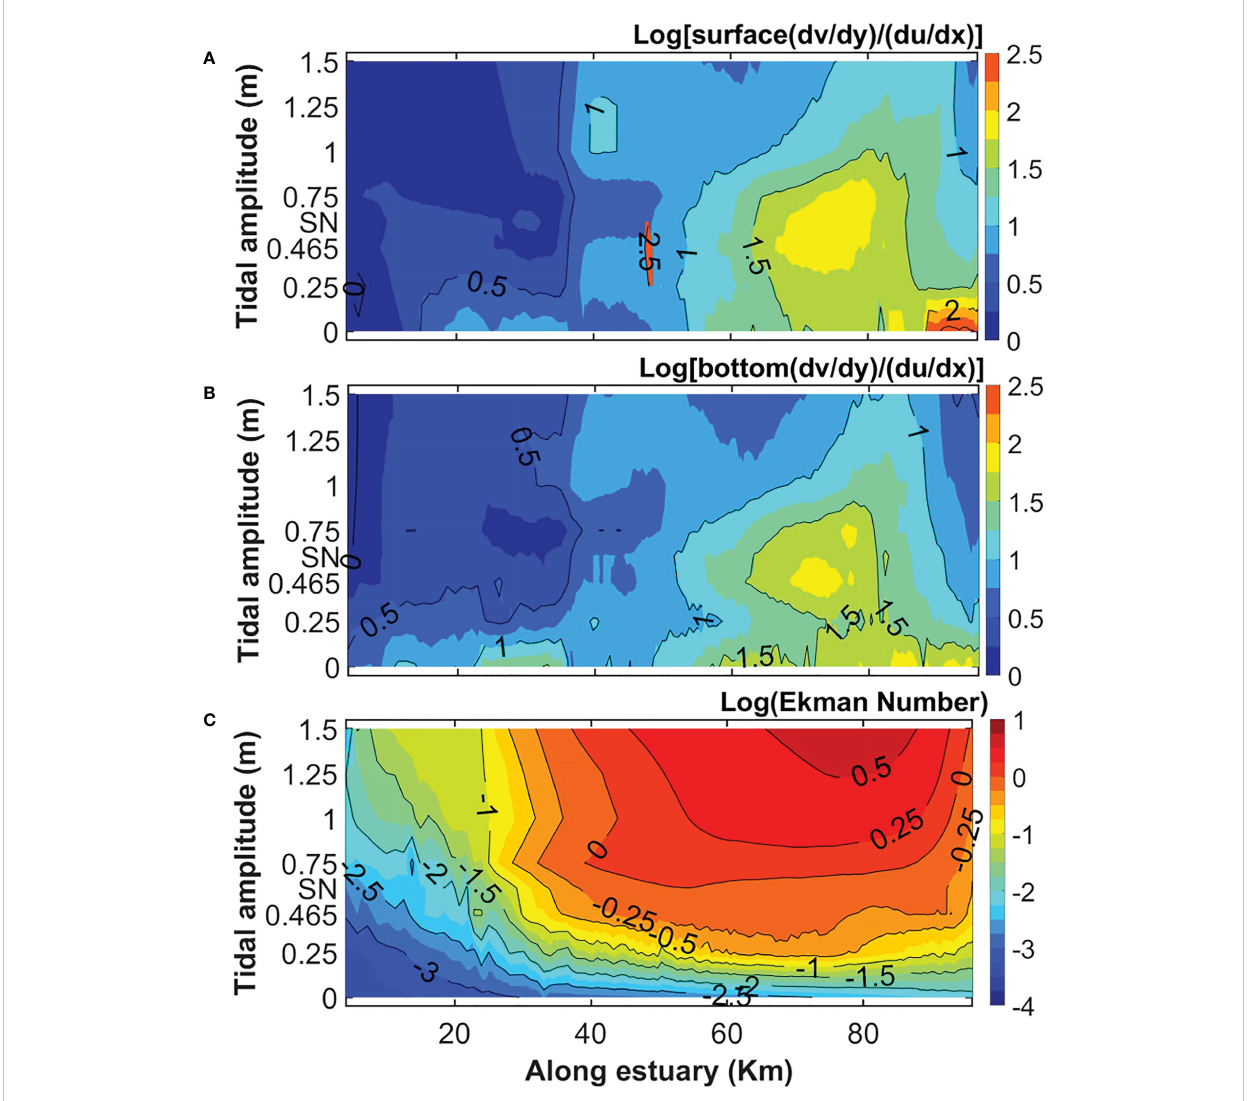
FIGURE 9 The logarithm of the ratio tidally averaged dv/dy to du/dx for surface (A) and bottom (B) layers as well as the logarithm of Ekman number (C) from 8 scenarios of EXP4-EXP11 (see Table 1), as a function of distance from the estuary mouth (x-axis) and tidal amplitudes at the estuary mouth (y-axis). “ SN ” on the y-axis stands for the spring-neap scenario of